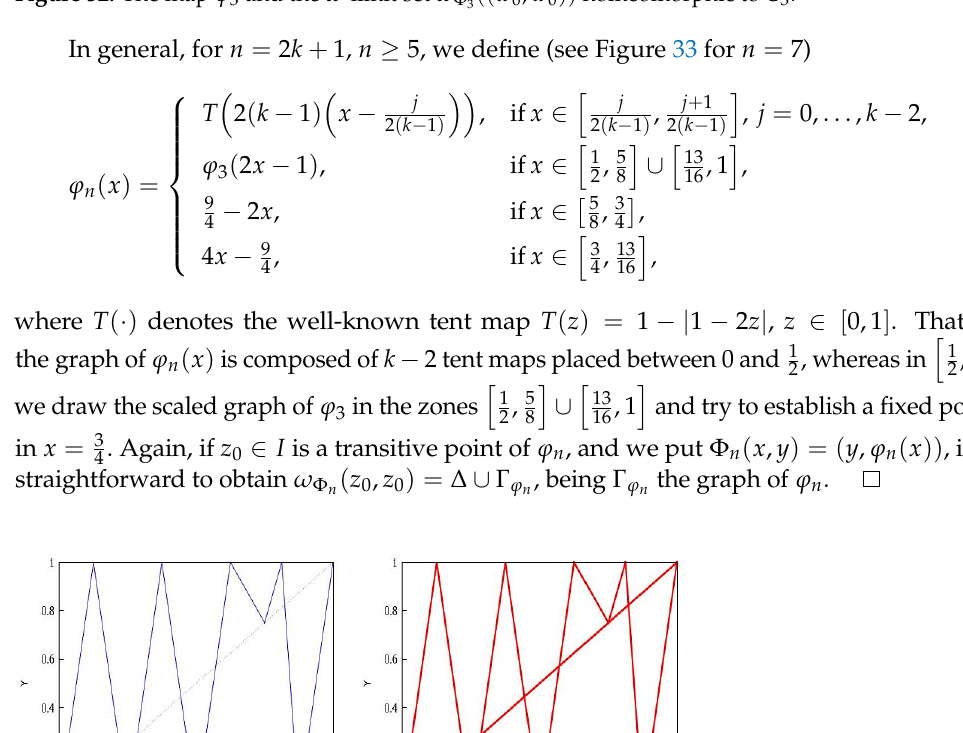
Figure 33. The map ϕ 7 and the ω -limit set ω Φ